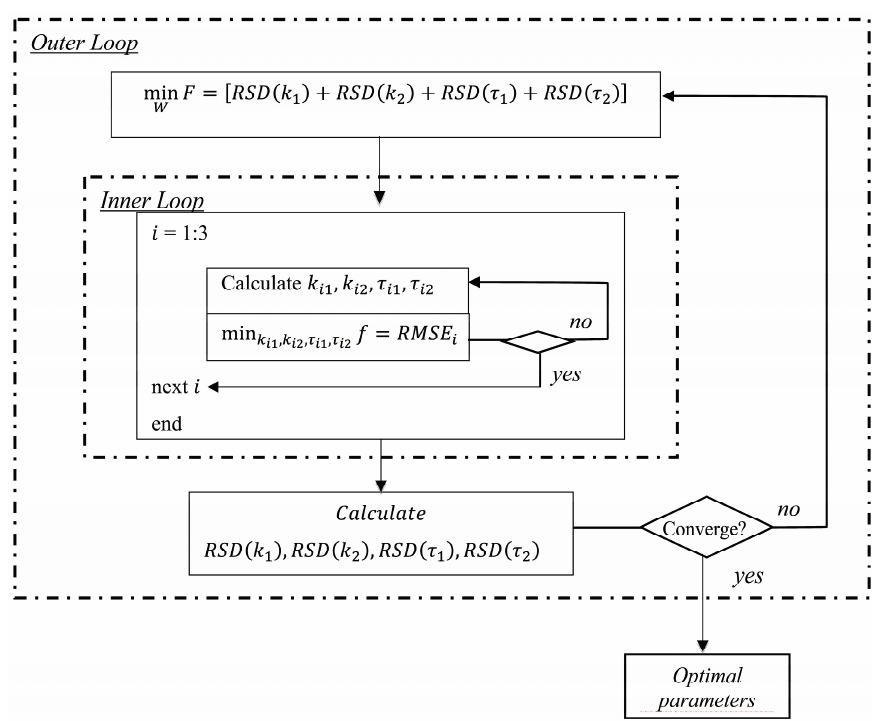
Figure 1. Block diagram of optimization